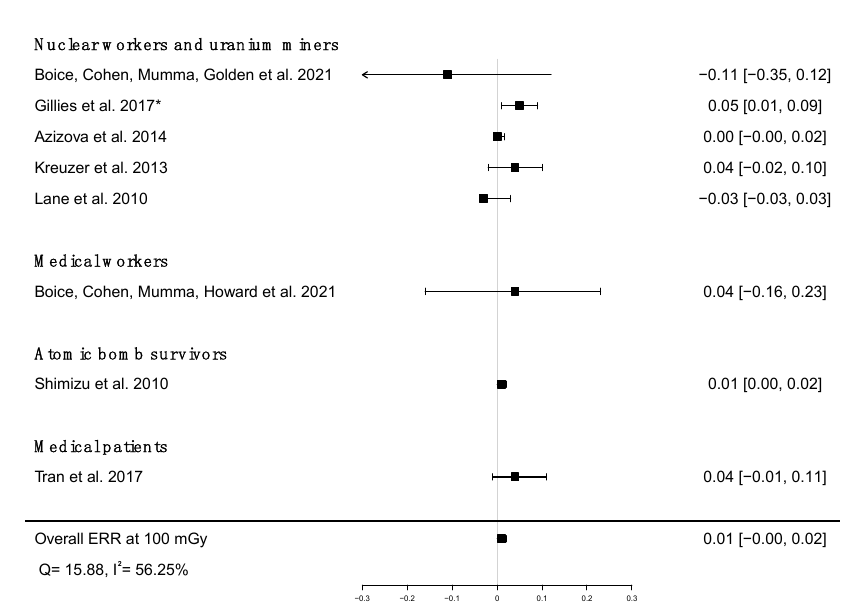
Figure 9. Excess relative risk (ERR) at 100 mGy and 95% confidence interval (CI) for mortality from cerebrovascular diseases in relation to IR exposure; * 90%CI.